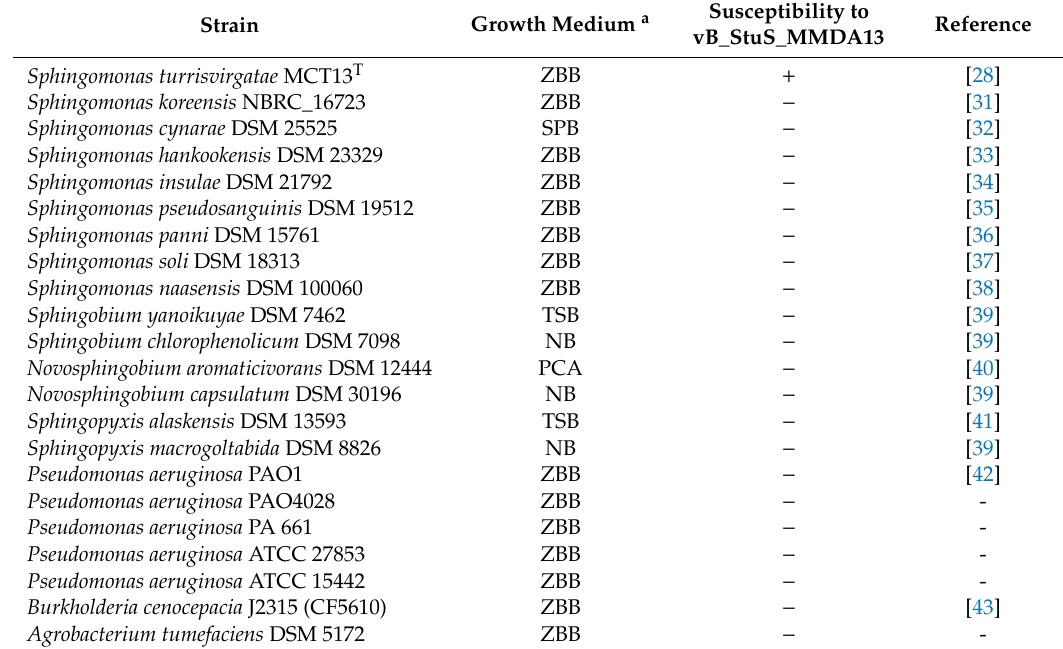
Table 1. Strains used for the determination of the vB_StuS_MMDA13 host range. + , lysed; − , not lysed.